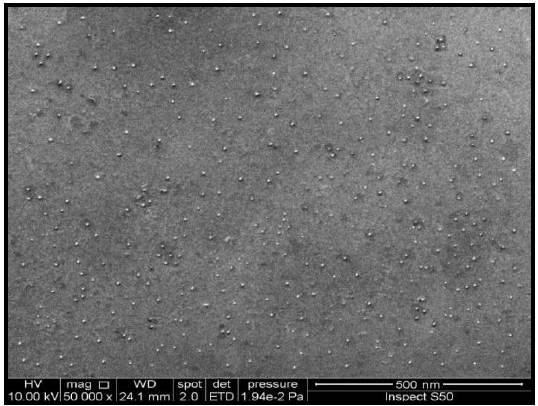
Figure 16. SEM images of the optimized